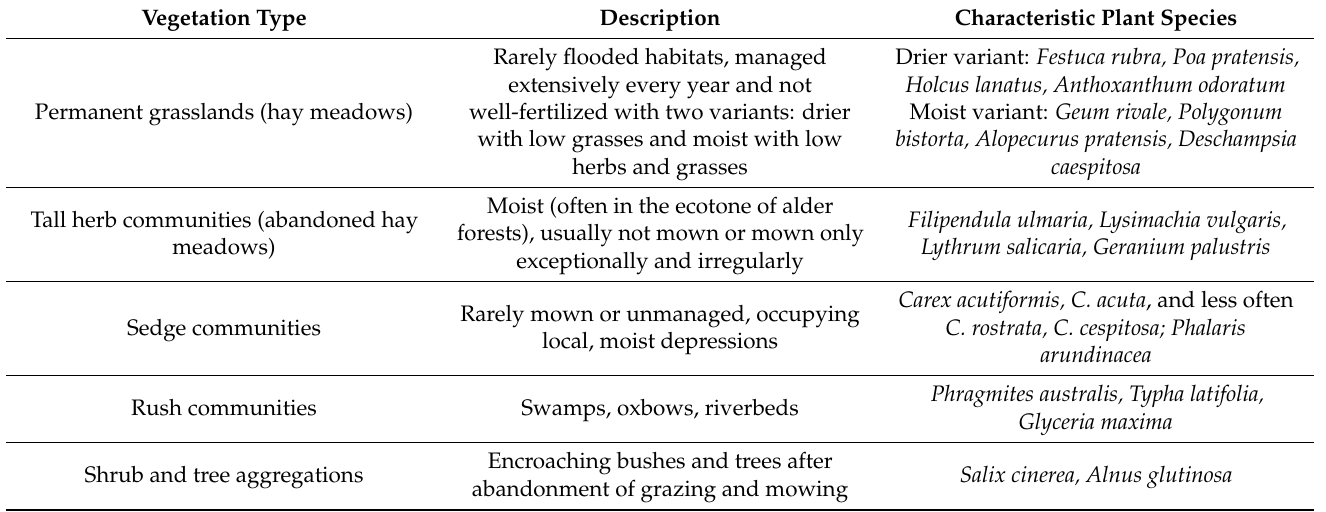
Table 4. Five dominant types of vegetation currently found based on historically transformed fens according to Kołos and Banaszuk